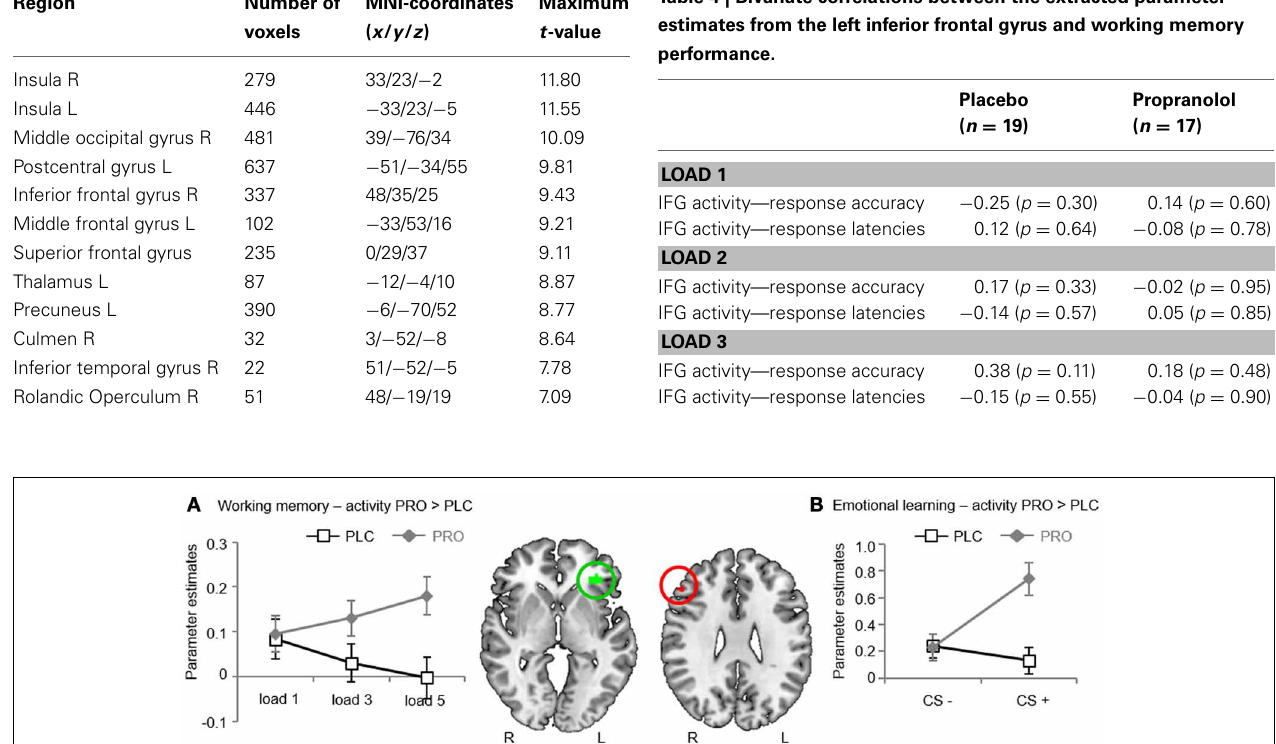
FIGURE 3 | fMRI results. (A) Experiment 1. During high working memory load propranolol-treated subjects showed stronger activity in the left inferior frontal gyrus (IFG). Plotting the individual extracted parameter estimates for the left IFG revealed that activity in this region increased with working memory load after propranolol, yet not placebo treatment. (B) Experiment 2.